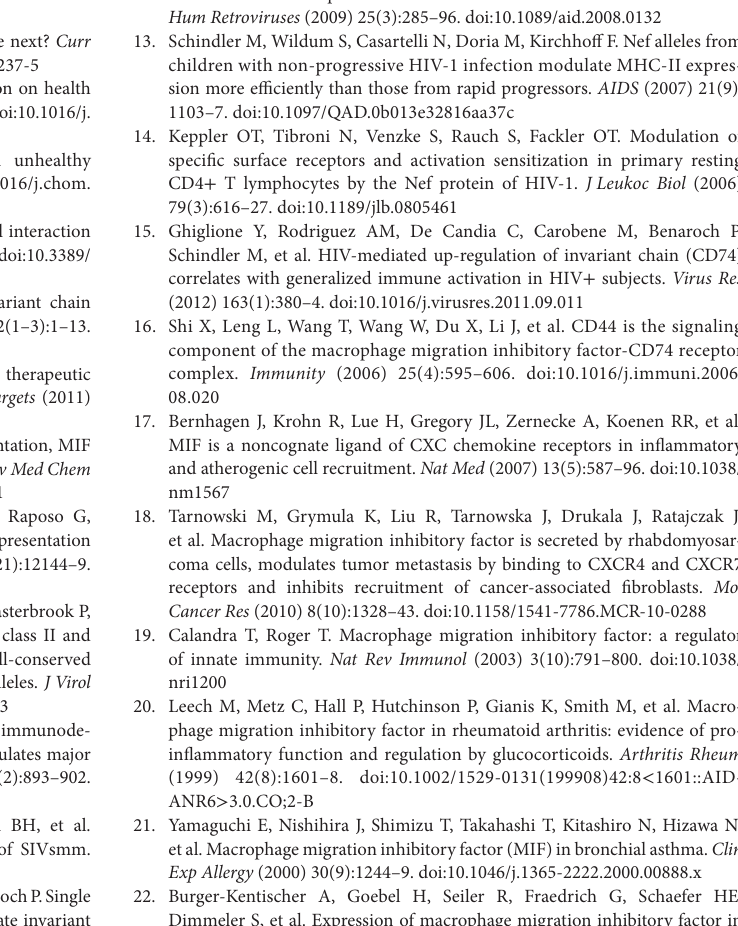
FigUre s1 | Gating strategy used for flow cytometry analysis of monocyte- derived macrophages (MDMs) (a) and CD4 + T-cells (B) . First, doublets were excluded in a forward scatter (FSC)-height (FSC-H) versus an FSH-area (FSH-A) plot. Then, living cells were gated an FSC-A versus a side scatter (SSC) plot. Subsequently, infected cells were identified in an FSC-H versus FITC plot (MDMs) or versus GFP plot (CD4 + T-cells). Data acquisition was performed in a BD FACSCanto flow cytometer using the BD FACSDiva software and analyzed subsequently with FlowJO v10 software (Data Analysis Software,